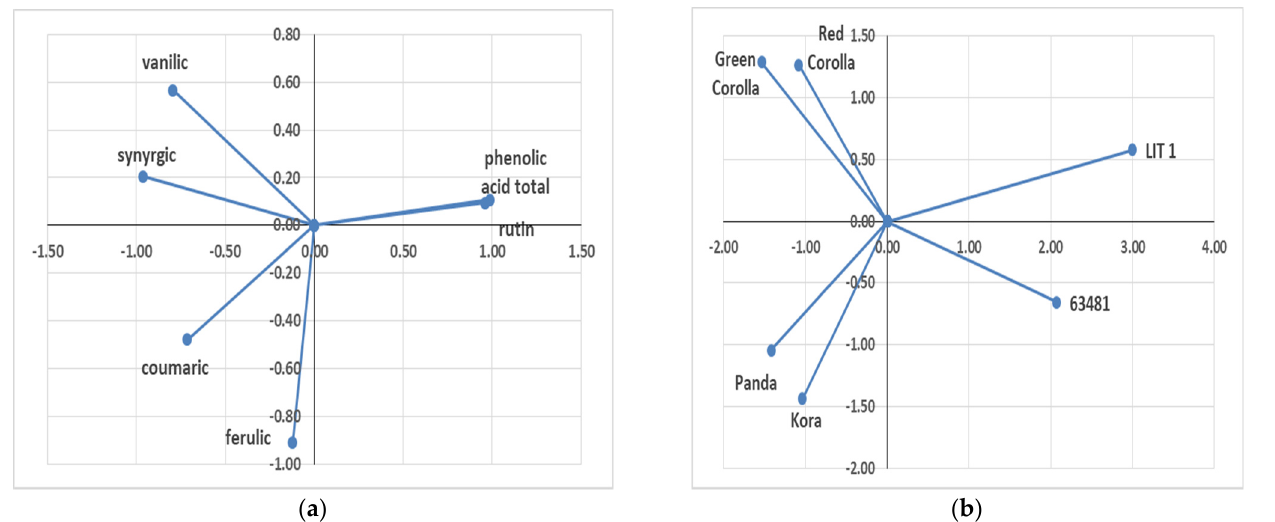
Figure 1. Principal component analysis (PCA) of seed bioactive compounds of F. esculentum and F. tataricum genotypes ( a ) and individual graph of the tested genotypes ( b ).